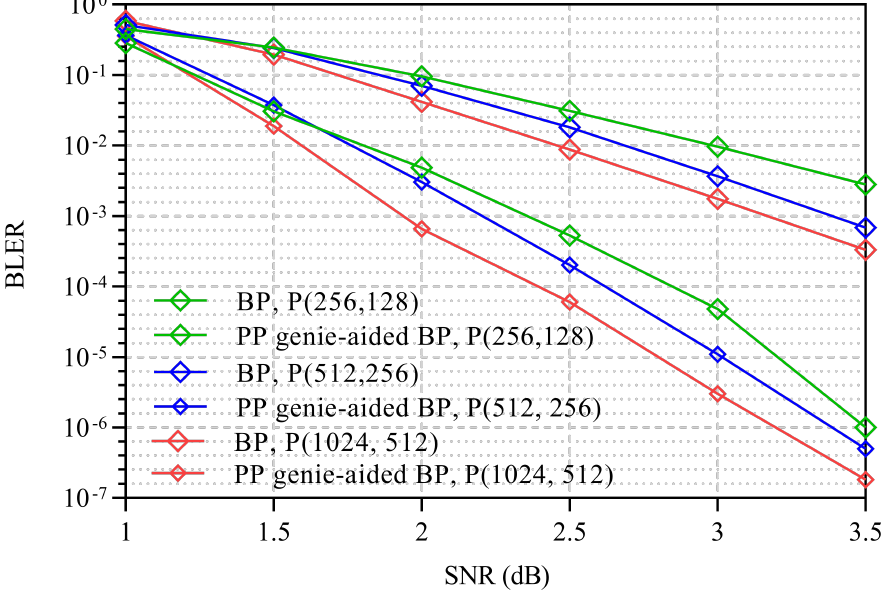
Figure 3. Block error rate (BLER) performance of the BP decoder and the preprocessing (PP) genie- aided BP decoder for P ( 256,128 ) , P ( 512,256 ) , and P ( 1024,512 ) .